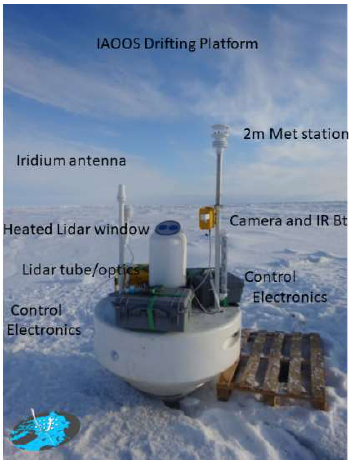
Fig. 1: Implementation of the instrumentation on the IAOOS platform Other sensors are adapted for temperature, salinity, gases and nutrients for measurements in the ocean [1]. Data are taken at regular intervals (up to 8 times per day) over a given period of time (minutes to an hour) Several platforms can be deployed each year, depending on the opportunities by the collaborations with groups